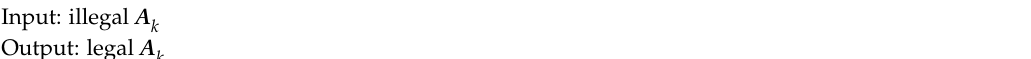
Figure 7. An example of discretization and legalization processes. Algorithm 2 Multi-sensor scheduling algorithm